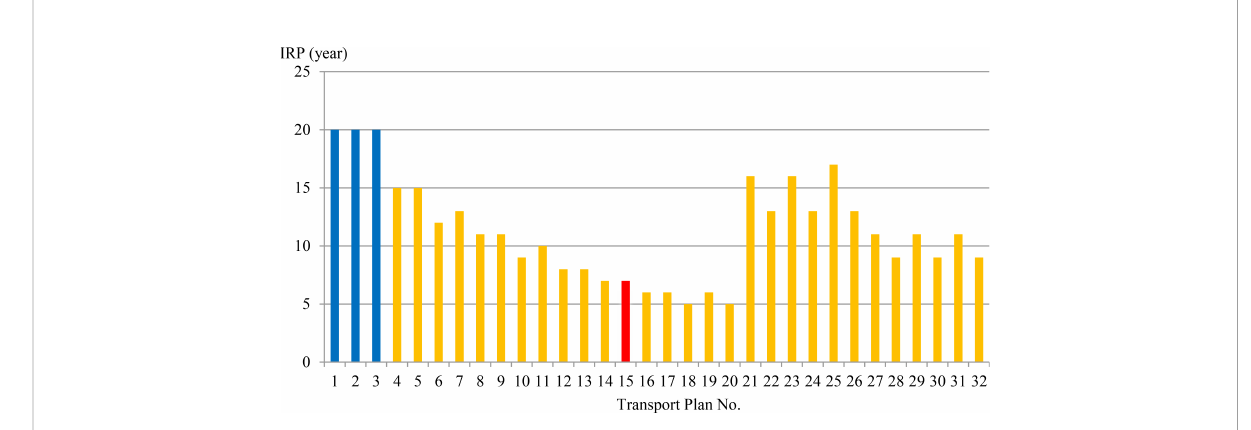
FIGURE 7 Investment recovery period (IRP) of all evaluated DSM vertical transport plans. An IRP of these transport plans less than 20 years is represented by the orange bars; the red bar is the most preferable and sustainable DSM vertical transport plan; the IRP of the transport plan No. (1-3) is equal to, or greater than 20 years. Here, they are simpli fi ed as 20 years and represented by the blue